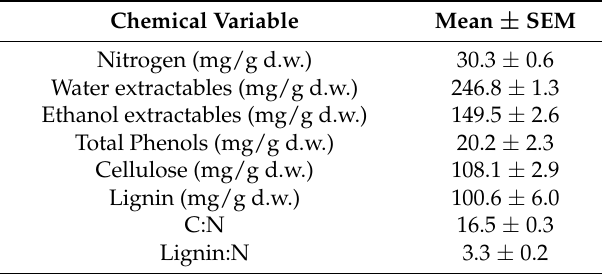
Table 1. Newly shed litter chemical composition. Values represent mean ± standard error of the mean ( N = 6).